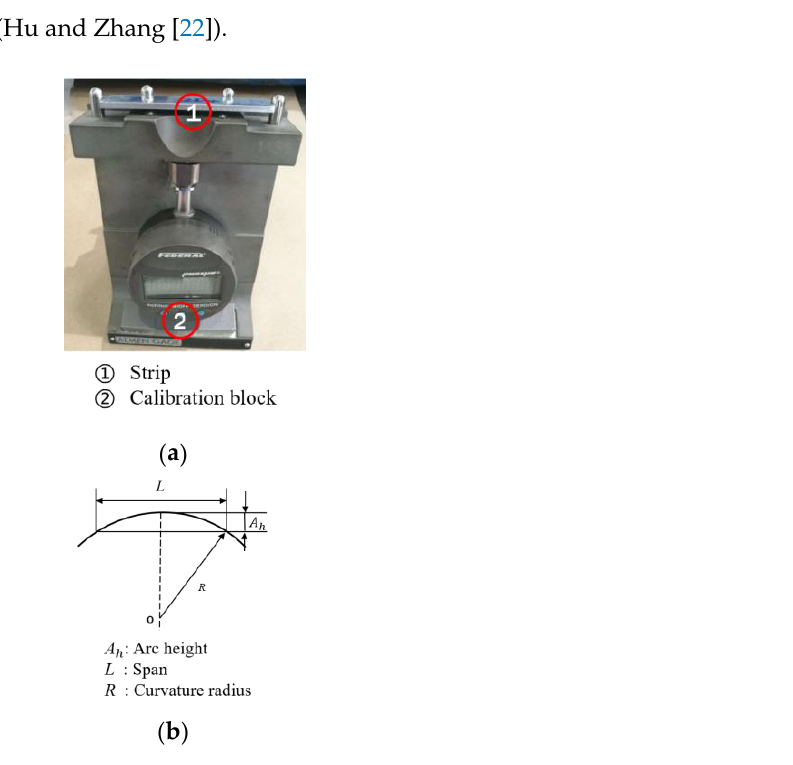
Figure 3. Measuring the arc heights of Almen strips. ( a ) Almen gauge. ( b ) Arc height measurement schematic.